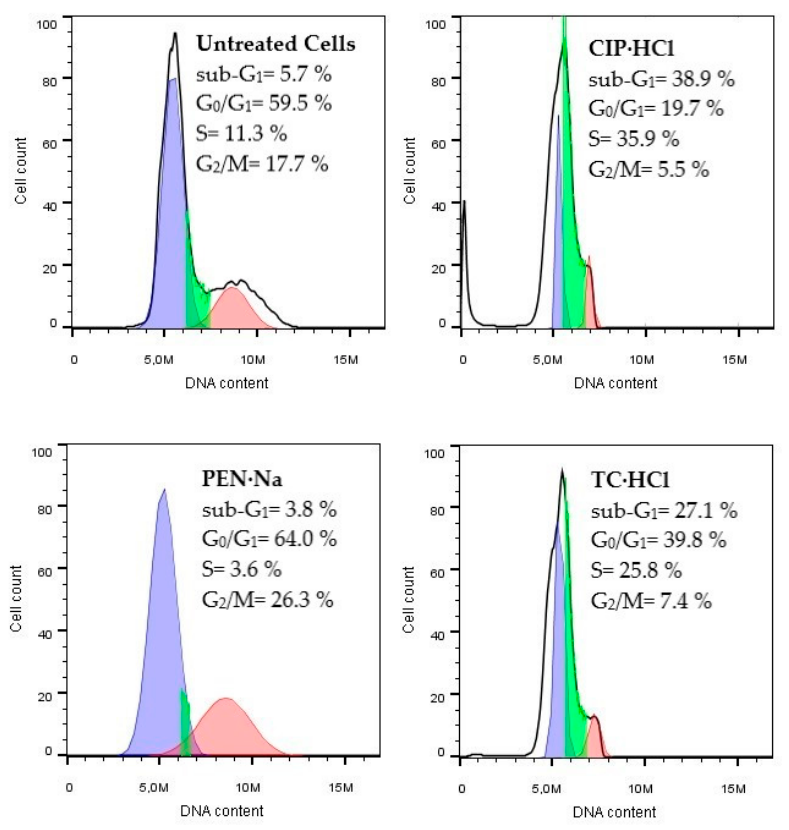
Figure 5. Effect of CIP · HCl , PEN · Na , and TC · HCl on MCF-7 cell cycle. The relative number of cells within each cell cycle was determined by flow cytometry. Number of cells in sub-G 1 , G 0 /G 1 , S, and G 2 /M phases are indicated .